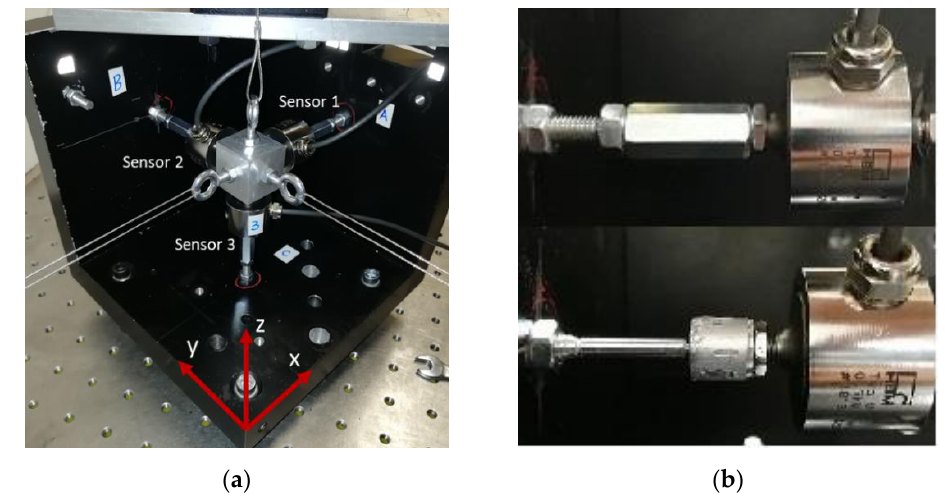
Figure 3. ( a ) Force sensors in tripod configuration, ( b ) Locknut Collar (above) and Necked collar (below).